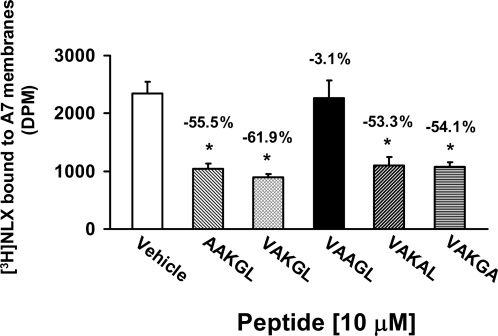
Mid-point lysine of FLNA2561–2565 is critical for NLX binding.An alanine scan of the FLNA2561–2565 pentapeptide (VAKGL) shows that residue of FLNA2561–2565 is critical for NLX binding. All other individual alanine substitutions only mildly attenuated [3H]NLX binding to FLNA in A7 membranes. n = 6. * p<0.01 compared to vehicle.